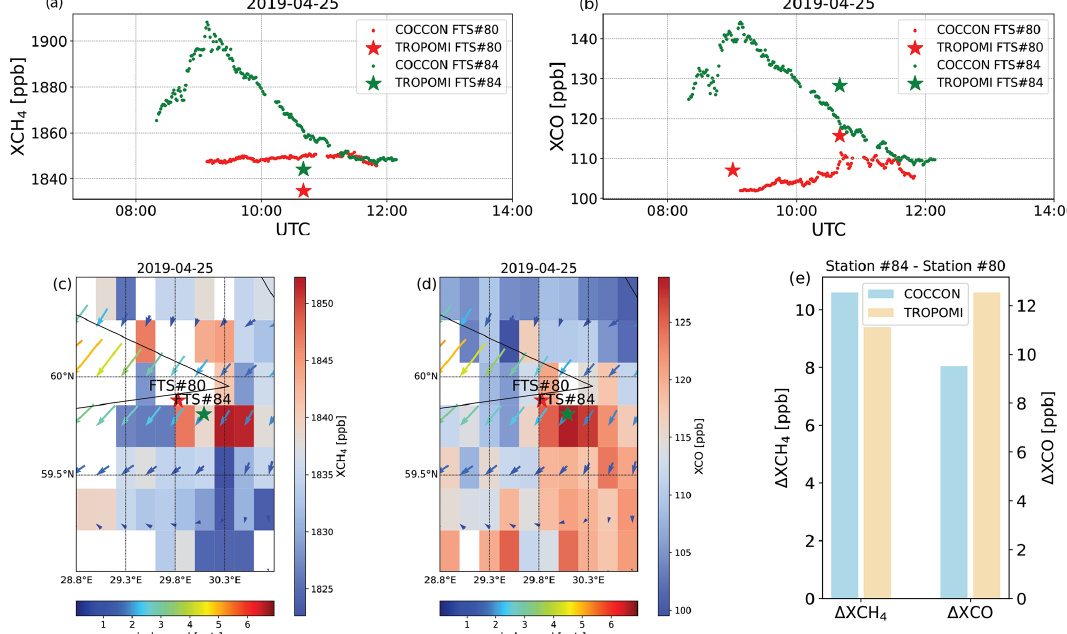
Figure 22. Time series of COCCON and coincident TROPOMI observations for XCH 4 (a) and XCO (b) ; spatial distribution of XCH 4 (c) and XCO (d) on a 0 . 1 ◦ × 0 . 1 ◦ latitude × longitude grid together with the ERA5 wind at 12:00UTC; (e) bar plot for XCH 4 and XCO gradients by COCCON and TROPOMI on 25 April